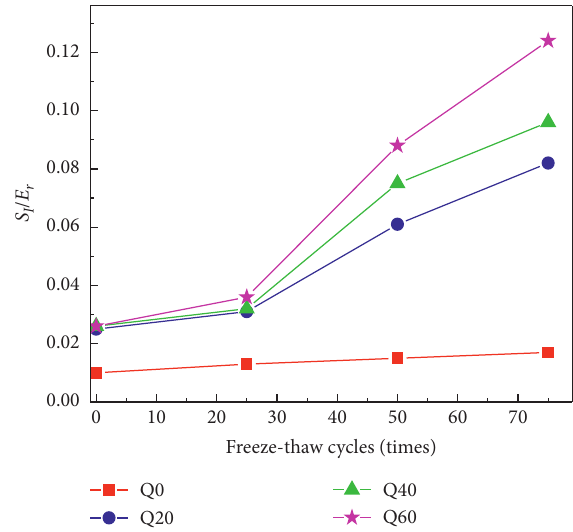
Figure 8: Variation of S I / E r with freeze-thaw cycles.